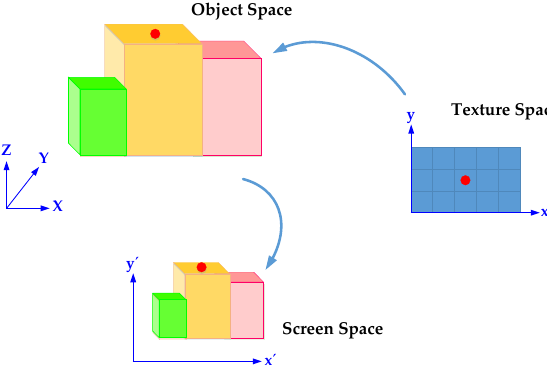
Figure 19. Transformations between texture, object, and screen spaces.